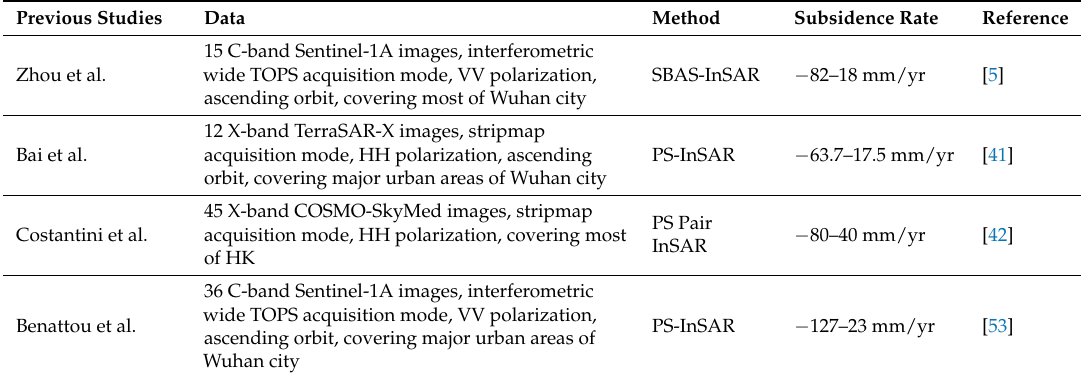
Table 2. Summary of the previous studies of land subsidence in Wuhan